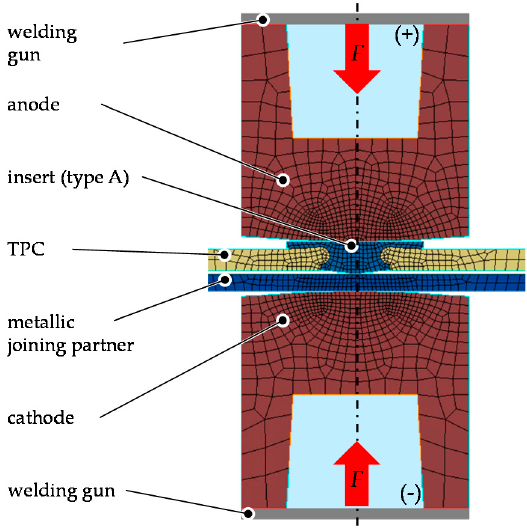
Figure 4. Two-dimensional (2D) axisymmetric model used for the simulation of the resistance element welding process.